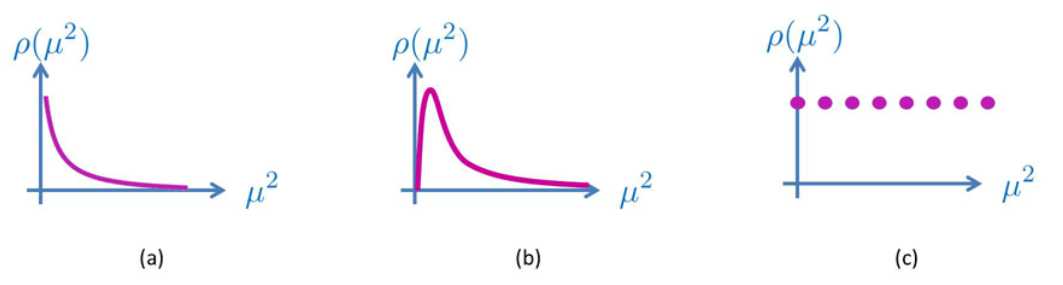
Figure 1: Spectral representation of different models. (a) DGP (b) higher-dimensional cascading gravity and (c) multi-gravity. Bi-gravity is the special case of multi-gravity with one massless mode and one massive mode. Massive gravity is the special case where only one massive mode couples to the rest of the standard model and the other modes decouple. (a) and (b) are models of soft massive gravity where the graviton mass can be thought of as a